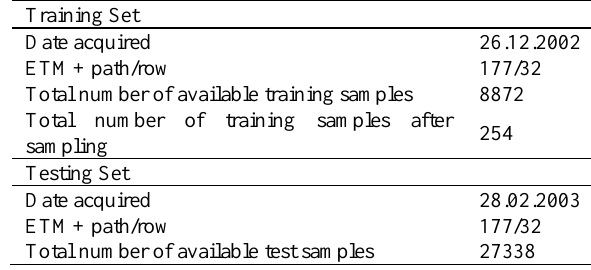
Table 1: Training and test data used in the